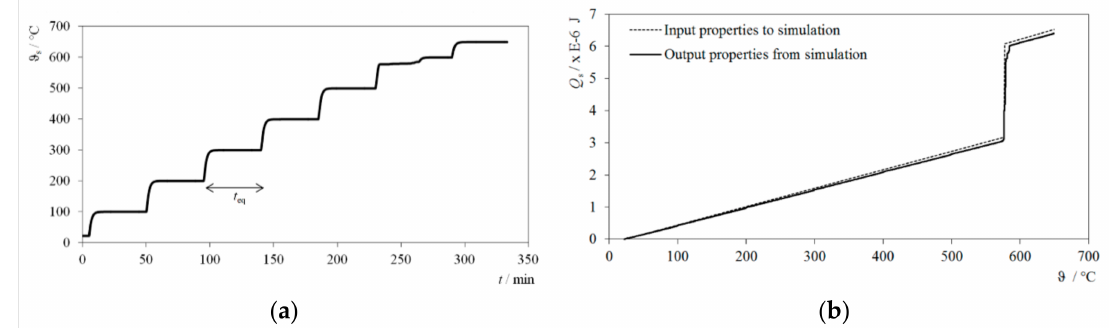
Figure 6. Results of stepwise adiabatic procedure. ( a ) Course of simulated sample temperature over time with t eq = 45 min. ( b ) Course of Q S curve resulting from simulation (solid) compared to curve resulting from simulation input values